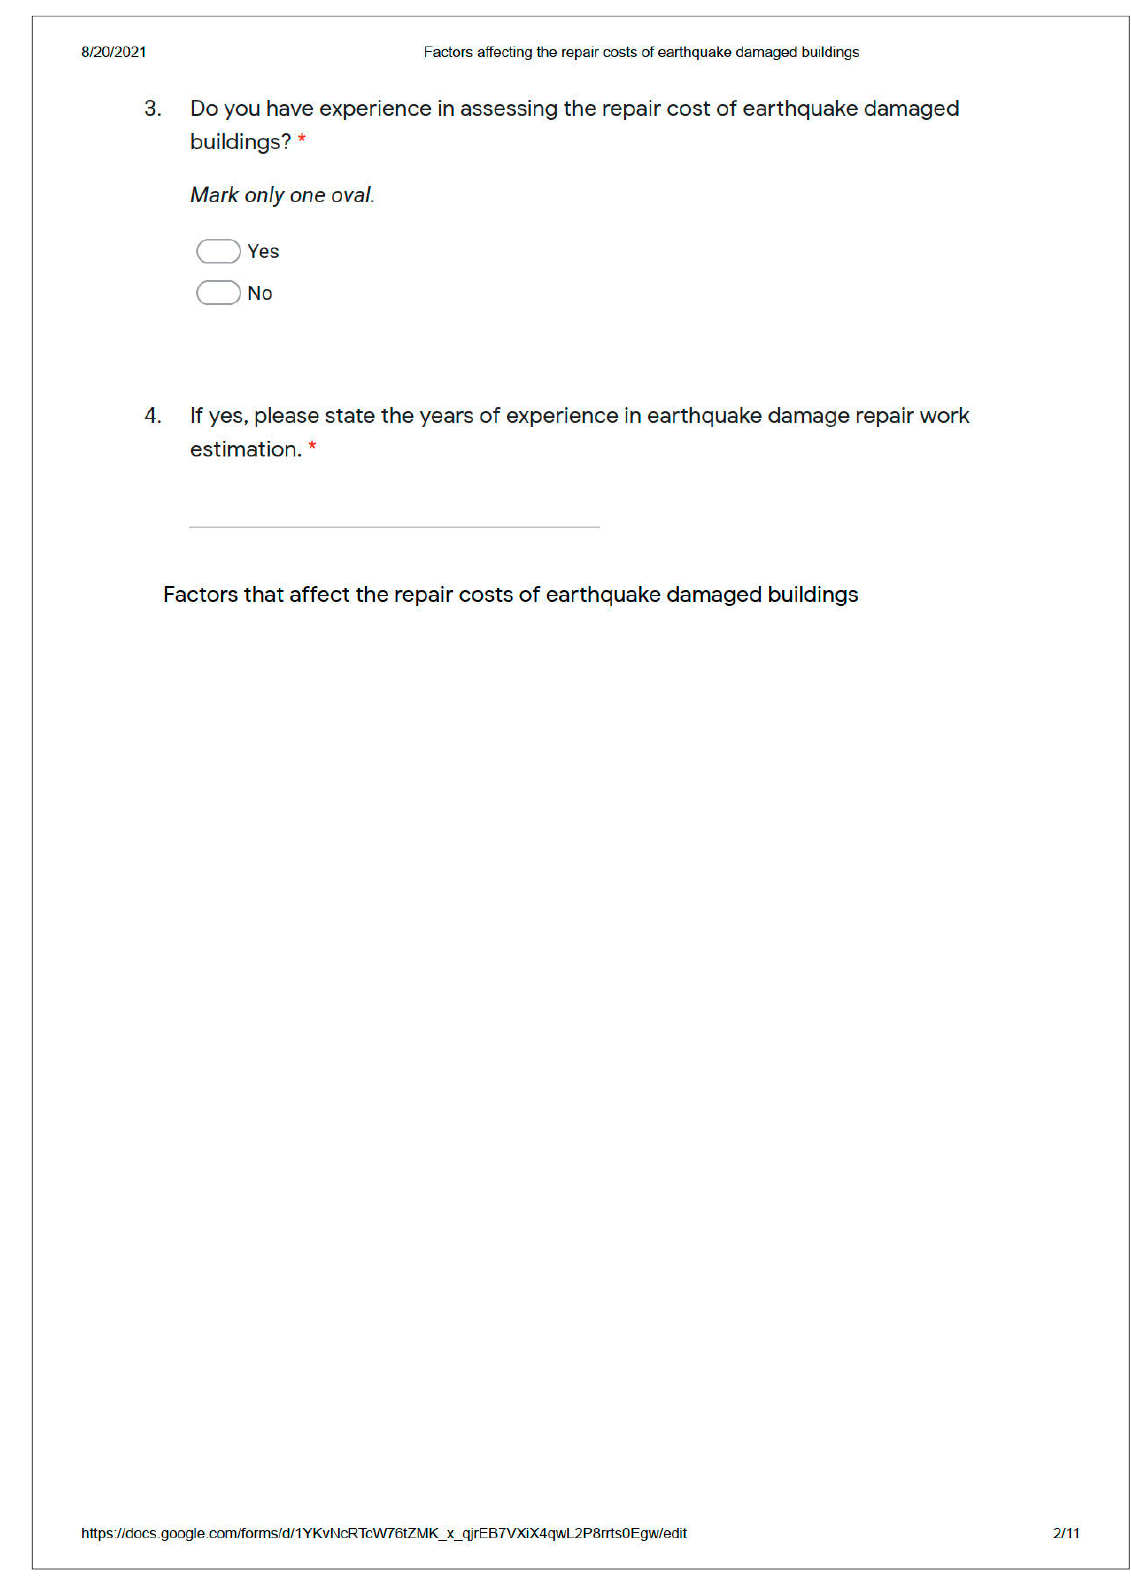
Figure A2. Questionnaire design (sample 2).